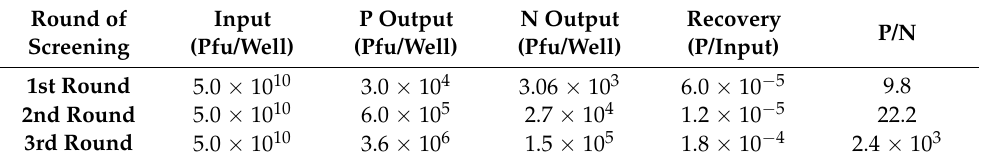
Table 1. Enrichment of phage particles against IBV-N protein specific nanobodies during three rounds of